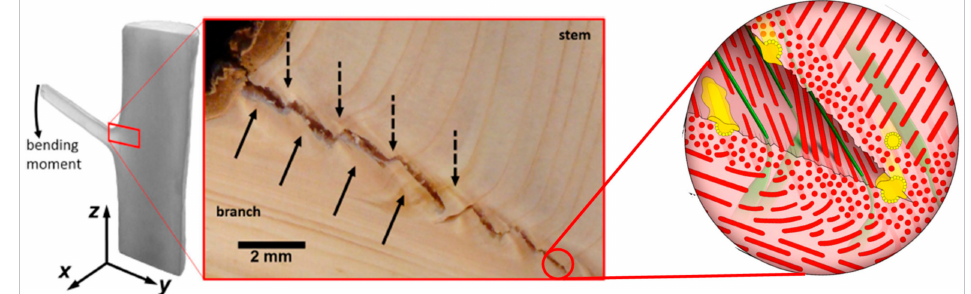
Figure 3. Zig-zag cracking of branch-stem interface with the model (insert) of the crack propagation in the sacrificial tissue. Wood rays (green) reinforced with tracheids (red) form tissue bundles responsible for crack bridging. High concentration of resin ducts (yellow) activated after the cracking ensures antimicrobial and hydrophobic protection. (reprinted with permission from Müller et al., 2015